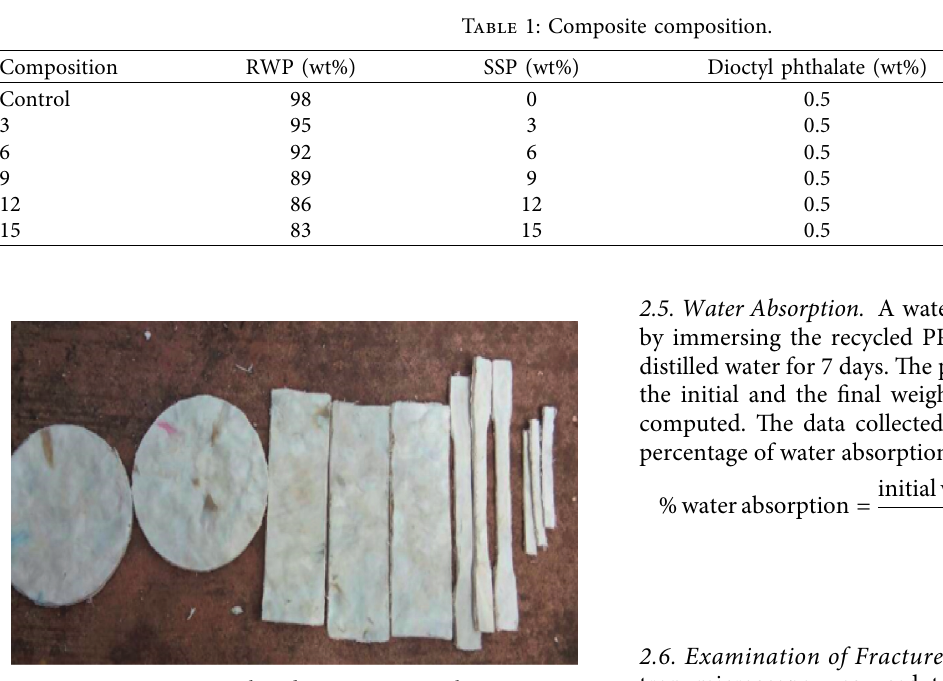
Figure 2: Developed composite